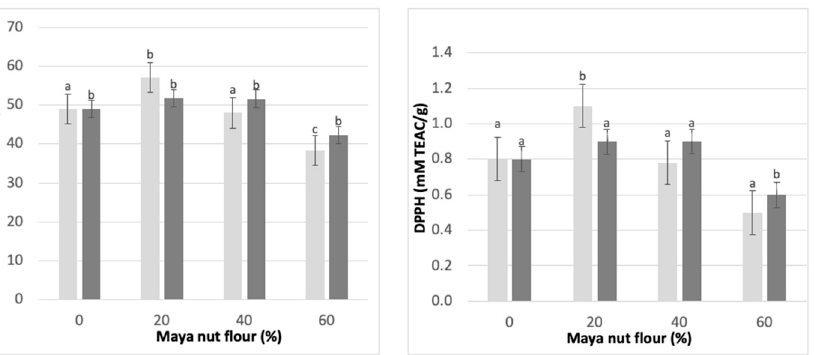
Figure 6. Antioxidant activity in Maya nut cookies by ABTS and DPPH radical. (cid:3) NF, naturally sun-dried flour and (cid:4) CF, commercial flour. Maya nut flour: 0%, 20%, 40% and 60%. Different letters indicate significant difference ( p < 0.05).